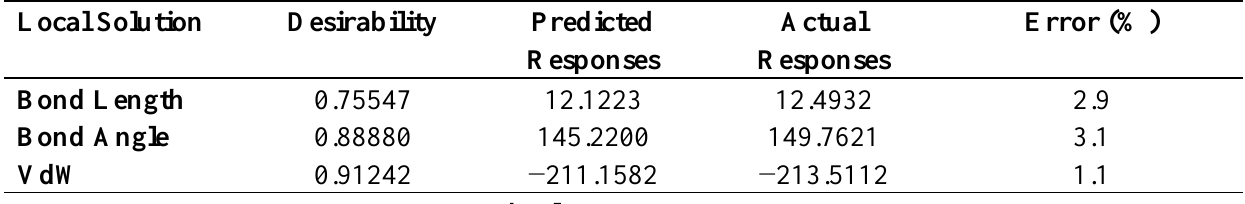
Table 12. Actual and predicted response values for the optimized